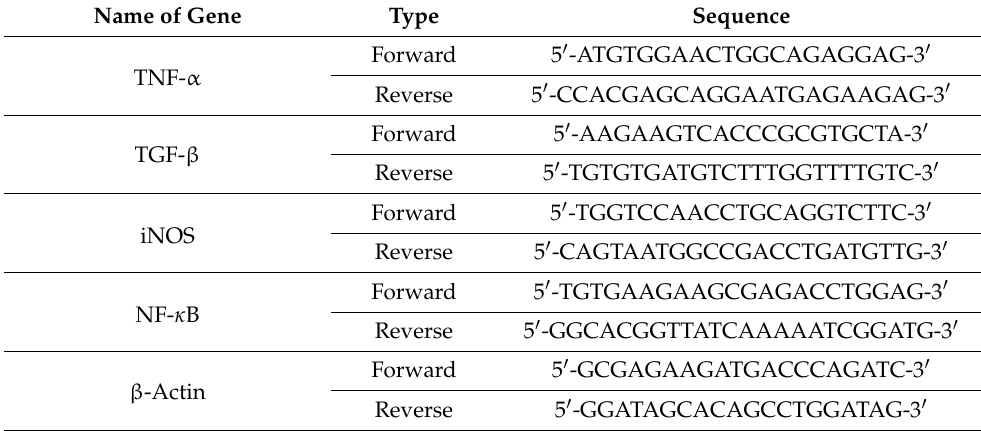
Table 1. Cont. Name of